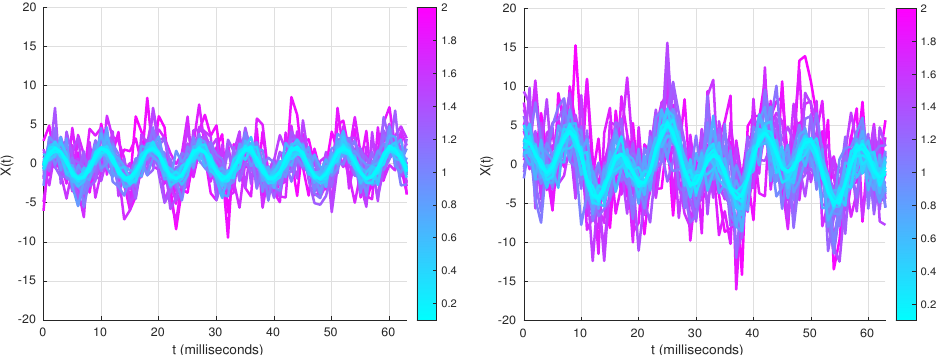
Figure 2. Graphs of two signals corrupted with noise of varying strength. The signal on the left has a single frequency, while the one on the right is a superposition of two signals of different frequencies and amplitudes. The colour bar on the right reflects the proportion of noise added to the signal, λ i .